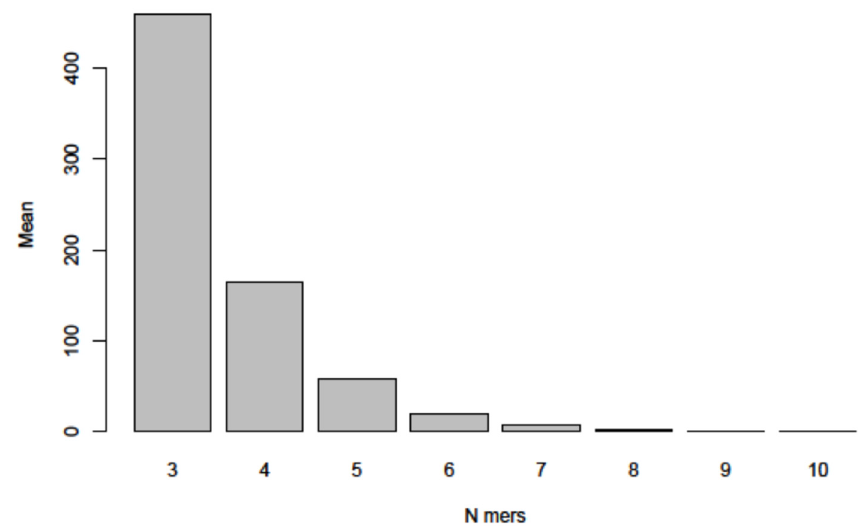
Figure 8. By using programs described under Methods, 1000 randomly generated nucleotide se- quences were computer-screened for sequence identities among these randomized sequences of 3- to 9-mers (up to 10-mers in rare instances).